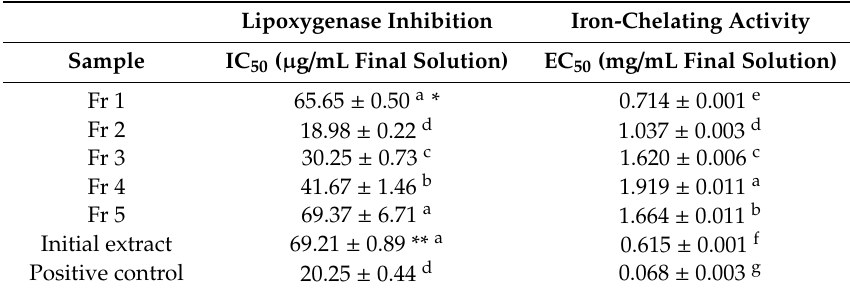
Table 3. Antioxidant activities of Z. elegans